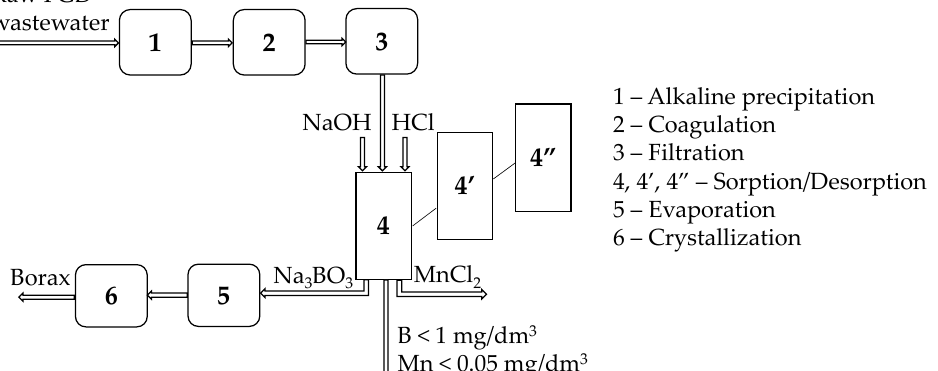
Figure 4. Block process flow sheet of the removal and recovery of boron.